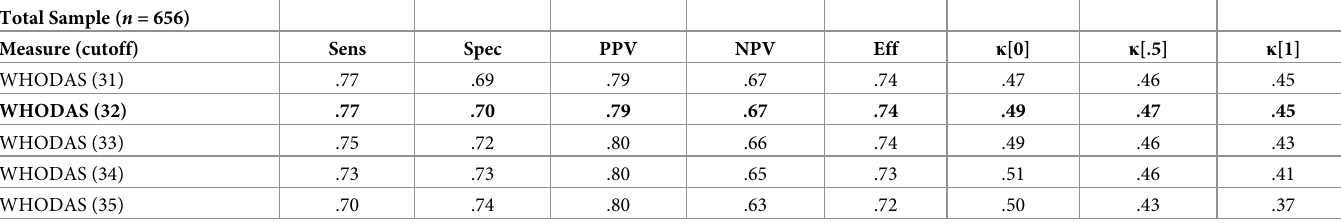
Table 3. Diagnostic utility of WHODAS total score for predicting functional impairment on the CAPS (either IV or 5). Total Sample ( n =